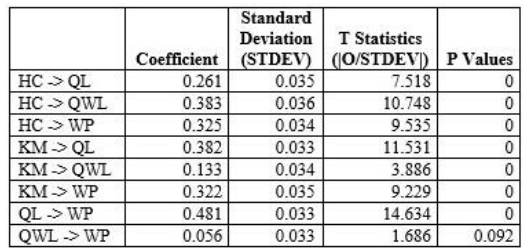
Table 13: Total Effect